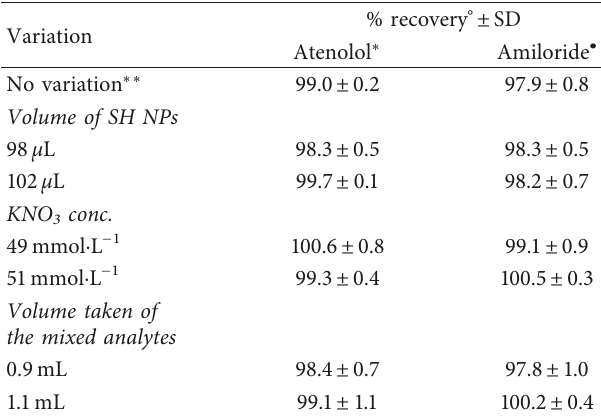
Table 3: Robustness results of the proposed